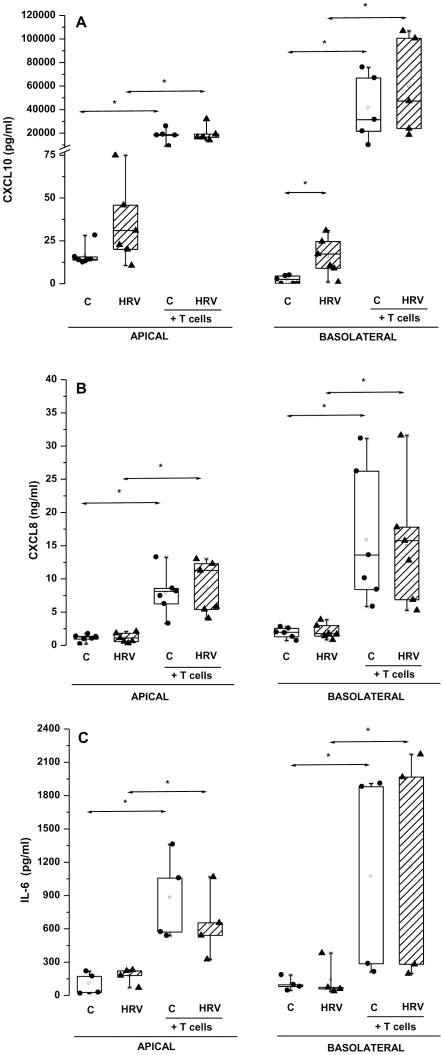
Both HRV14 and T cells enhance CXCL10, but only T cells enhance CXCL8 and IL-6 protein secretion by HNEC.HNEC were either not infected (C) or exposed apically to HRV14 alone (HRV), and co-cultured or not with activated T cells (T cells). The production of CXCL10 (A), CXCL8 (B) and IL-6 (C) was measured in apical and basolateral culture supernatants. Shown are the boxplots with the 25th, 50th (median), 75th percentiles, the mean (open square), the maximum and the minimum values. *p<0.05. In co-cultures experiments, the amounts of cytokines/chemokines released by epithelial cells in the basolateral compartments were determined by subtracting the amounts of cytokines/chemokines measured in the culture media of activated T cells cultures alone (undetectable for CXCL10, 0.034 ng/ml for CXCL8, 10.6 pg/ml for IL-6, median).